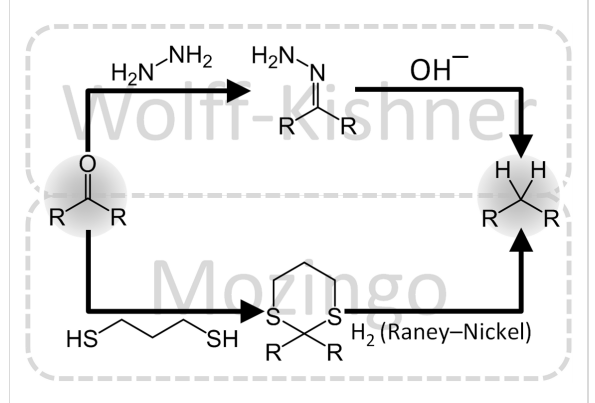
Figure 3: Comparison between Wolff–Kishner and Mozingo reduction. Notably the overall chemical reaction is the same for both